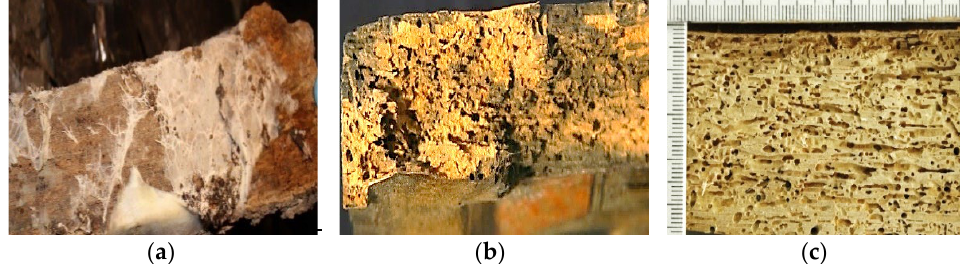
Figure 4. Degradation of the wood support; ( a ) fungal attack ( Serpula lacrymas ); ( b ) symbiotic at- tack; ( c ) xylophagous attack. ( c ) xylophagous